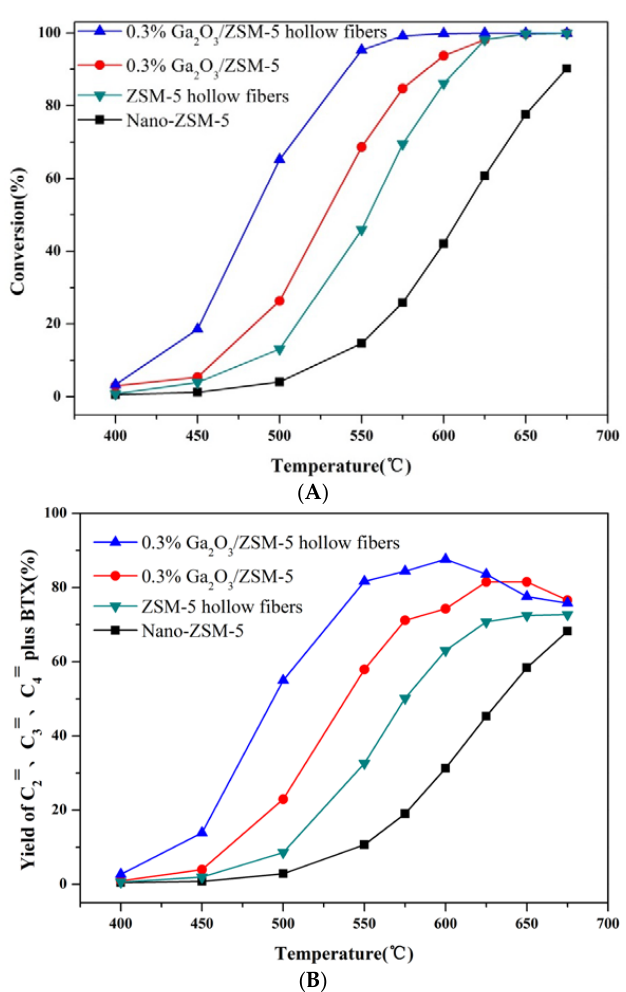
Figure 8. The conversion of n -butane (A) and the yield of C 2= , C 3= , C 4= plus BTX (B) as a function of reaction temperatures: 0.3% Ga 2 O 3 /ZSM-5 hollow fibers, 0.3% Ga 2 O 3 /ZSM-5, ZSM-5 hollow fibers, and Nano-ZSM-5.